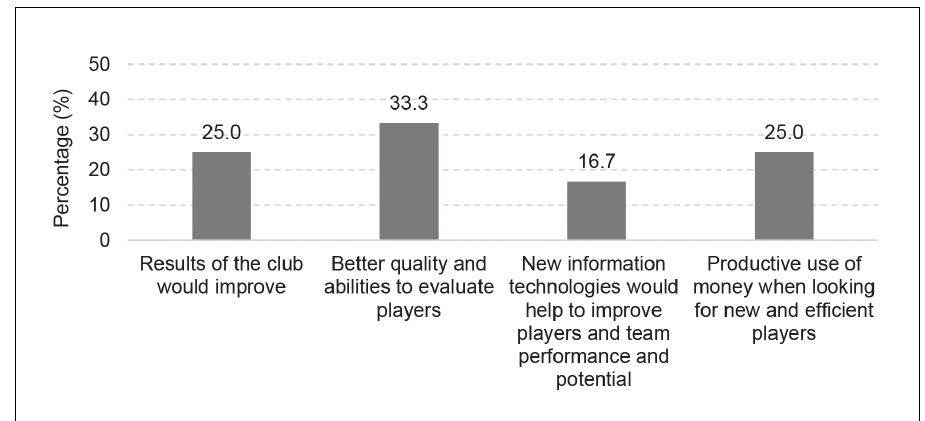
Figure 1. Respondents’ ans- wers of perceived value